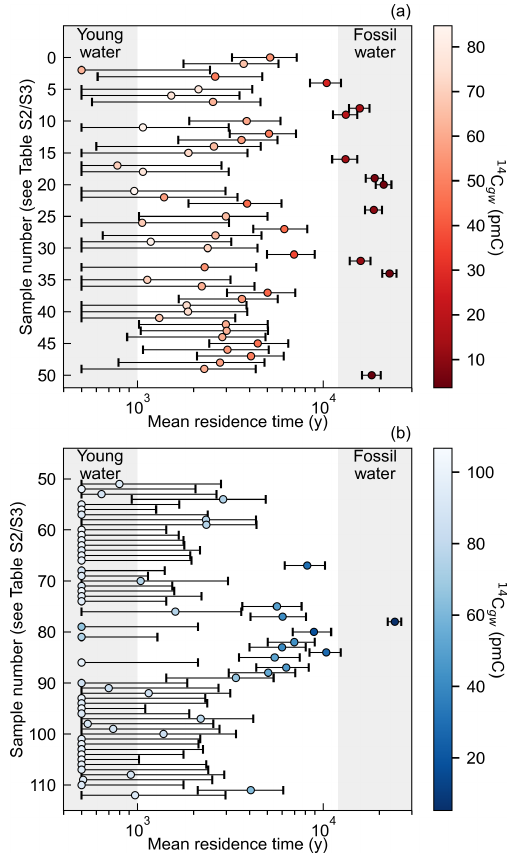
Figure 4. Mean residence times determined using the best fit re- lationship (Eq. 2, circle markers), the upper limit (Eq. 3, upper whisker) and the lower limit (Eq. 4, lower whisker). For sam- ple numbers ( y axis); see Tables S2 and S3 in the Supplement. (a) MRTs from the Limestone Coast region and (b) MRTs from the Ovens/Goulburn–Broken catchments. In both panels, shading denotes the measured 14 C gw activities.